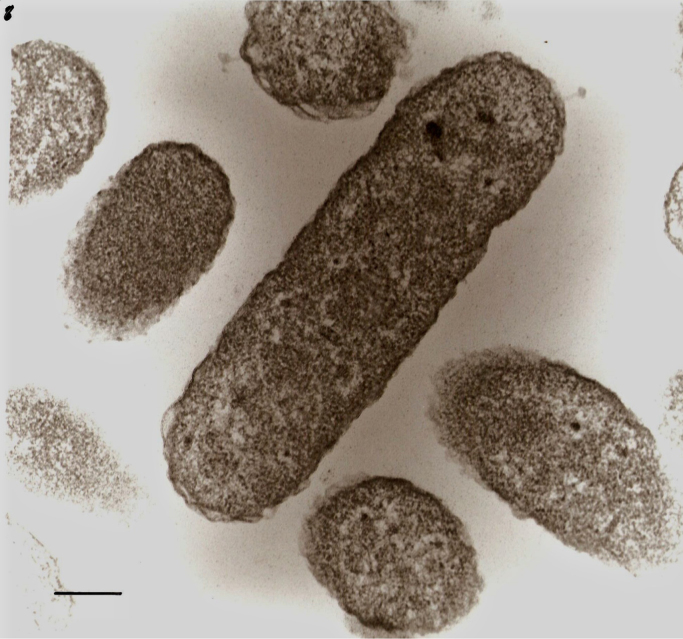
Transmission electron micrograph of intact S. olleyana suspended in MH buffer and stored at −86°C. Bar, 0.25 μm.